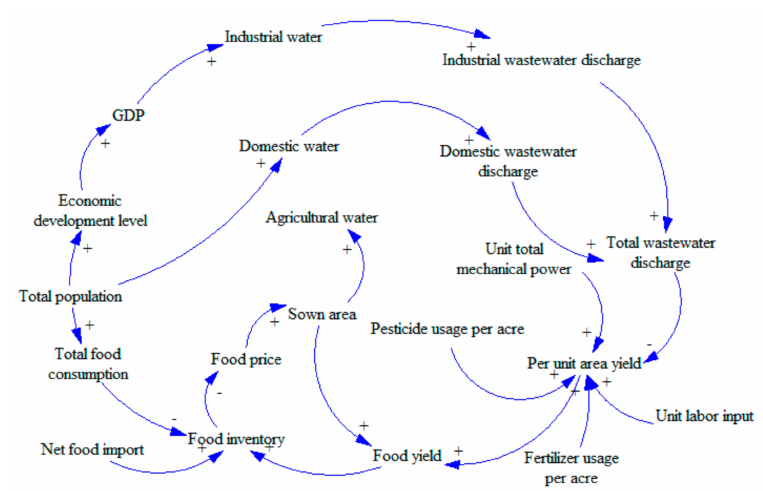
Figure 2. Causality diagram of China’s food